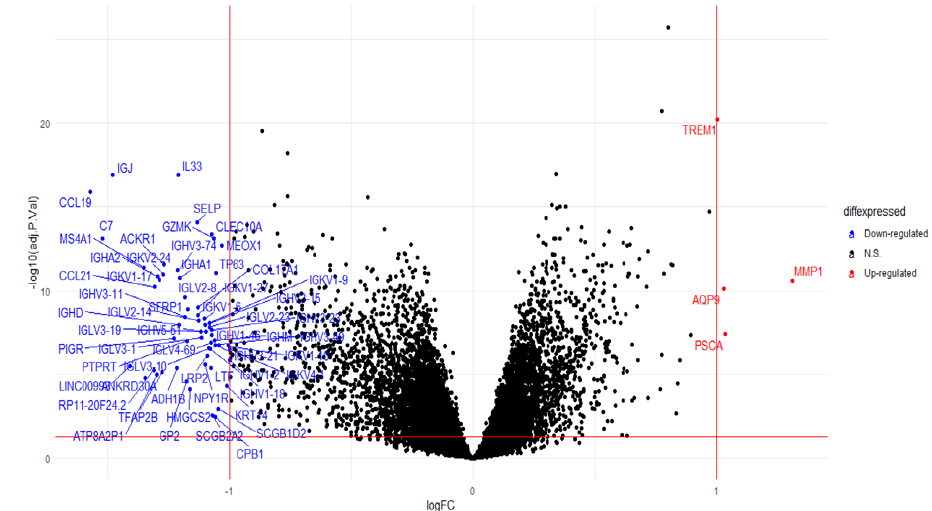
Figure 8. Volcano plot for the differential gene expression. Four genes were upregulated while 59 genes were downregulated in the high-risk group as compared to the low-risk group with the adjusted p value < 0.05 and |Log2(fold change) | > 1.